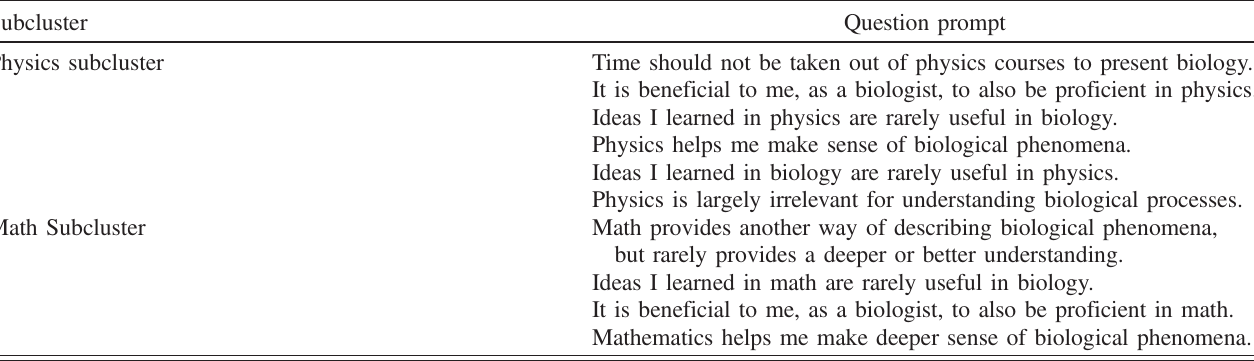
TABLE IV. Items from the Interdisciplinary